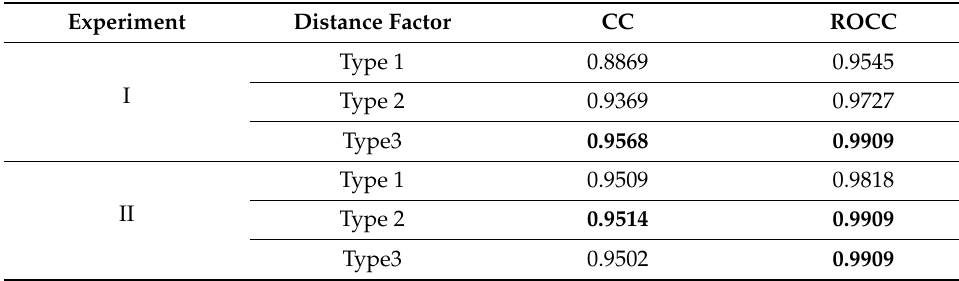
Table 1. Performance of three distance factors.